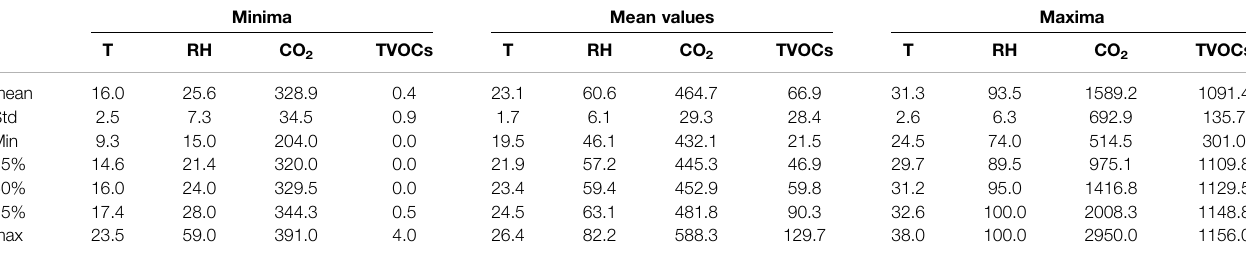
TABLE 2 | Statistical analysis across all MyAir sensors and over the entire observation period (Feb 2019 – Jun 2020). Minima Mean values Maxima